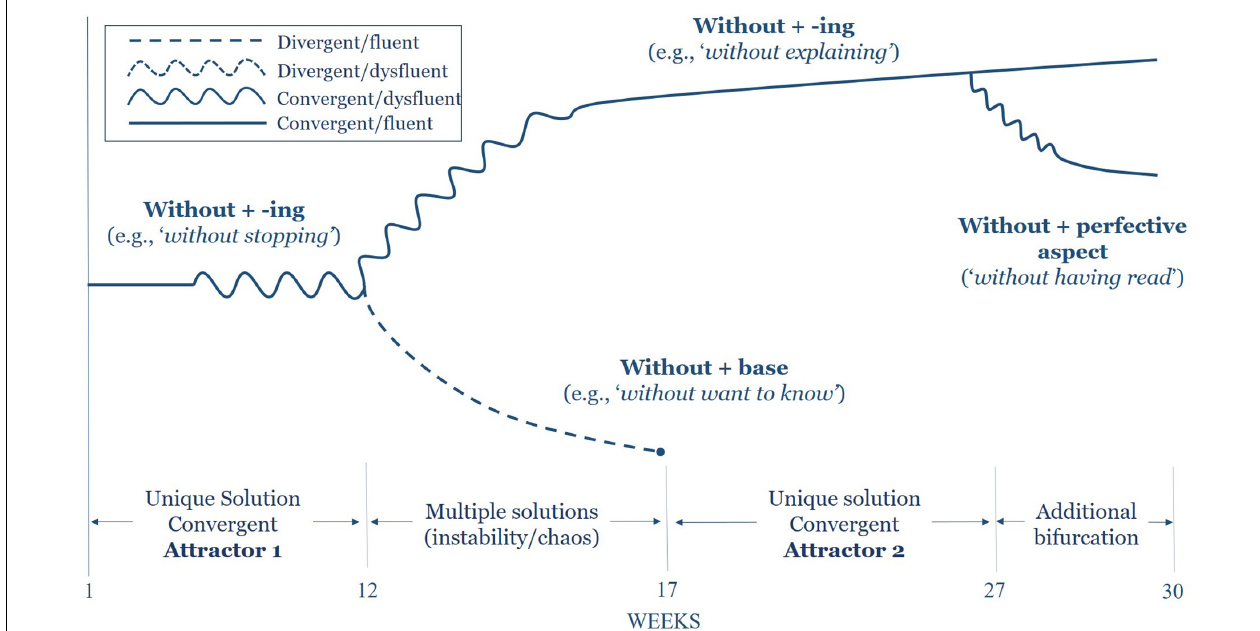
FIGURE 2 | Bifurcation region of without-headed non-finite adverbial clauses.